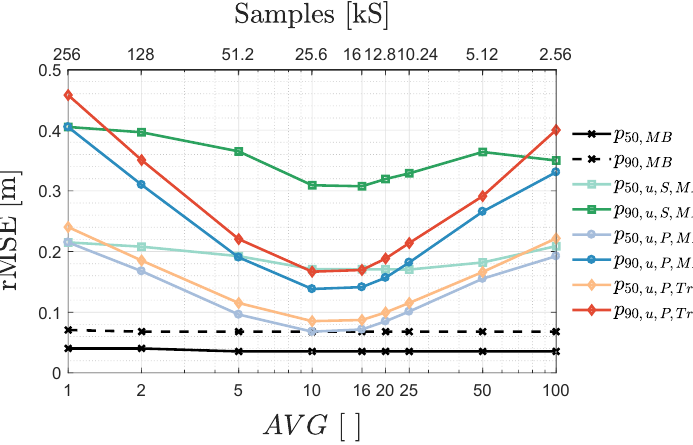
Figure 9. Influence of the AVG parameter on the p 50 and p 90 found both during FFT demodulation- and MBFB-based positioning in VLP (in black), uVLP SPECT (subscript ‘ u , S ’, in green) and PEAK systems (‘ u , P ’, in blue), and during trilateration (Tril)-based uVLP PEAK (in the red shades). ‘MBFB’ is abbreviated to